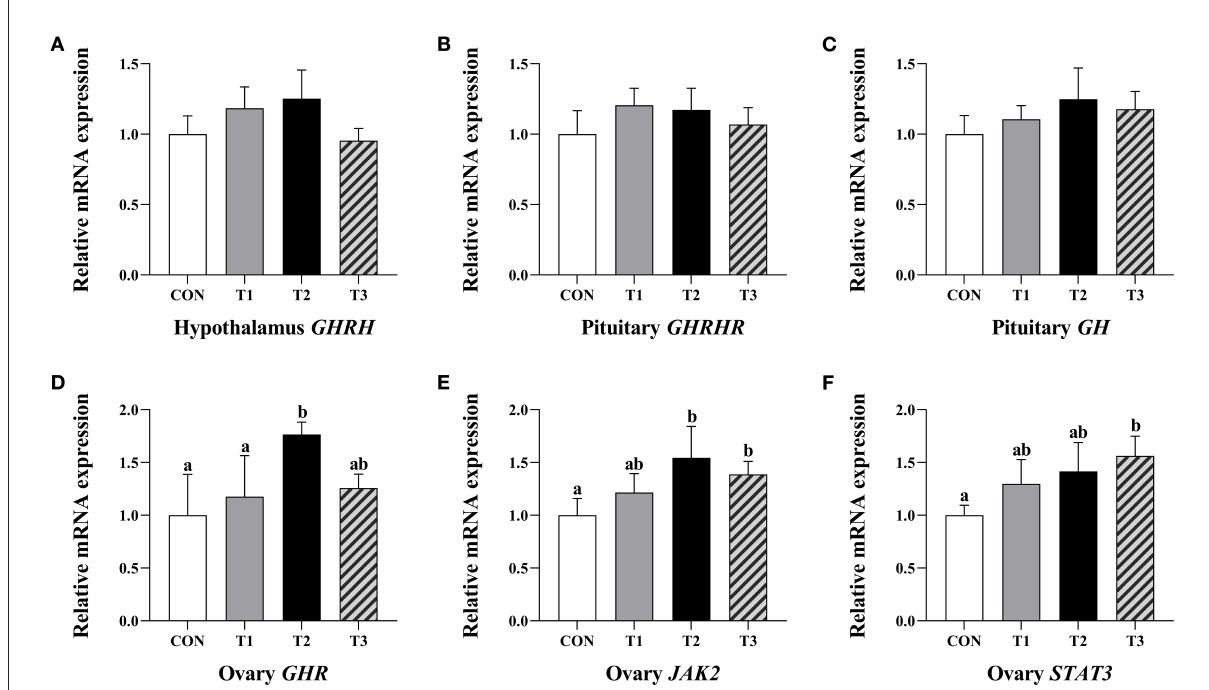
FIGURE3 Effects of ZEN on the relative expression level of hypothalamus GHRH gene (A) , GHRHR (B) and GH gene (C) in the pituitary and GHR (D) , JAK2 (E) , and STAT3 genes (F) in the ovary of prepubertal gilts. The mRNA level of genes were determined by qRT-PCR. Bars represent the means ± standard deviation (SD) ( n = 12). Above the bar no letter or the same letter mean no significant ( P > 0.05), while with different letter mean significant difference ( P < 0.05). Growth hormone-releasing hormone ( GHRH ), Growth hormone-releasing hormone receptor ( GHRHR ),